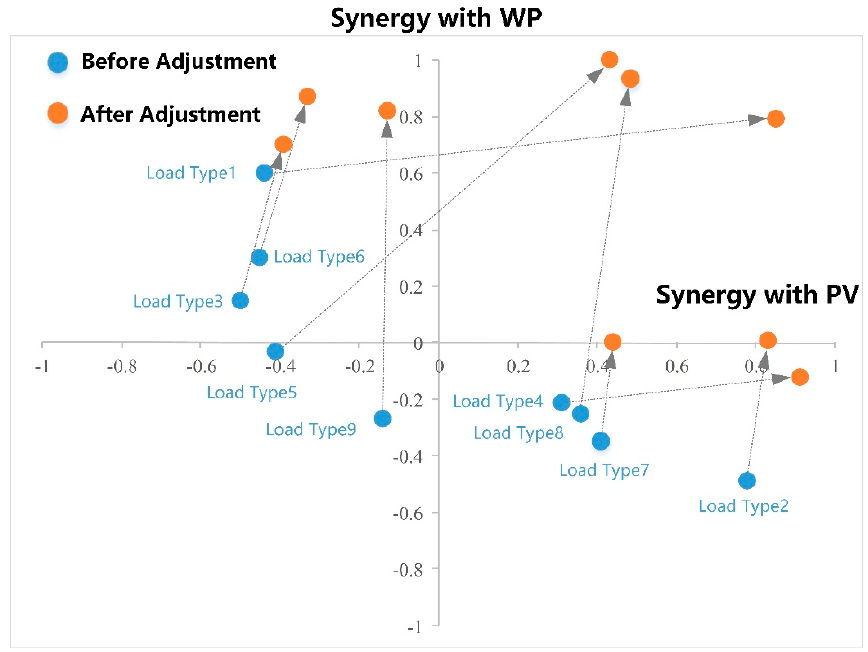
Figure 9. Synergy between different types of loads and new energy output.